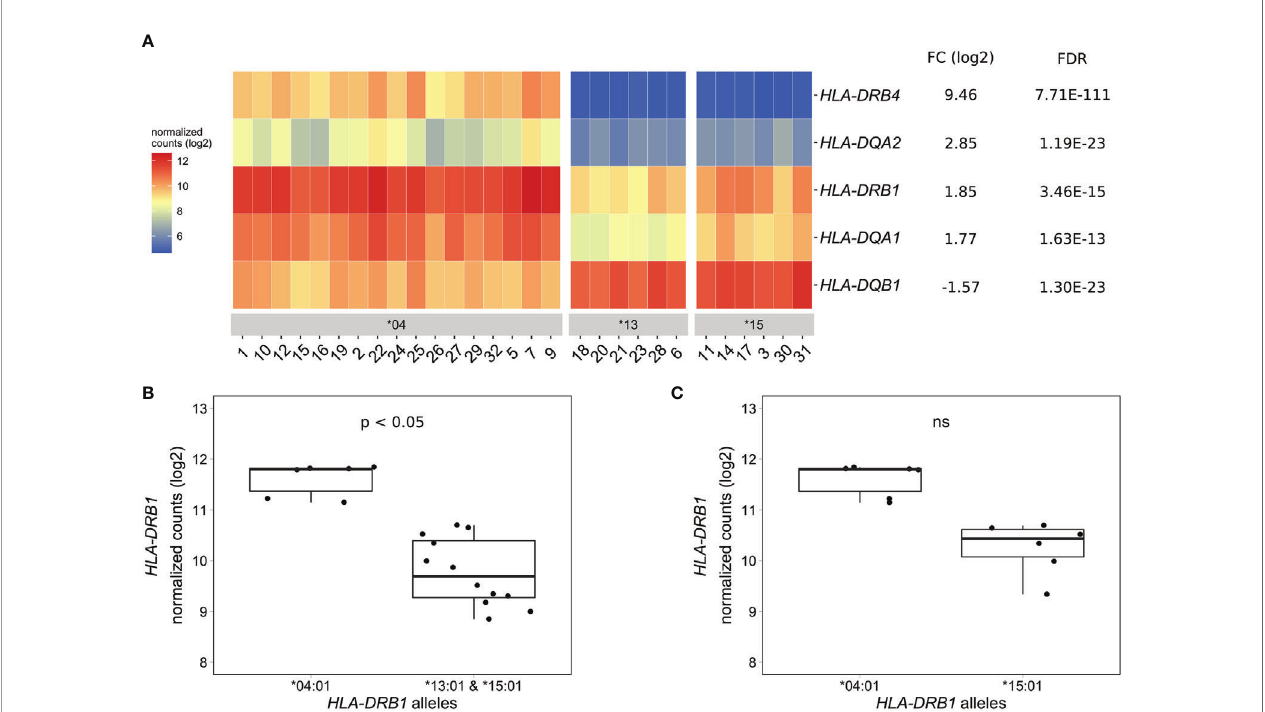
FIGURE 2 | Differentially expressed MHC Class II genes in PBMCs of HLA-DRB1 SE-positive versus SE-negative healthy individuals. (A) Heat map of differentially expressed genes (log transformed normalized gene counts) in PBMCs of HLA-DRB1 SE-positive [*04 ( n = 17)] versus SE-negative [*03:01/*13:01 and *03:01/*15:01 ( n = 12)] individuals. Genes shown in red have higher gene counts and those shown in blue have lower gene counts. (B) HLA-DRB1 gene expression in PBMCs of HLA-DRB1 SE-positive [*03:01/*04:01 ( n = 6)] and SE-negative [*03:01/*13:01 and *03:01/*15:01 ( n = 12)] individuals. (C) HLA-DRB1 gene expression in PBMCs of HLA-DRB1 SE-positive [*03:01/*04:01 ( n = 6)] and SE-negative [*03:01/*15:01 ( n = 6)] individuals. FC, fold change; ns, non-signi fi cant adjusted P -value